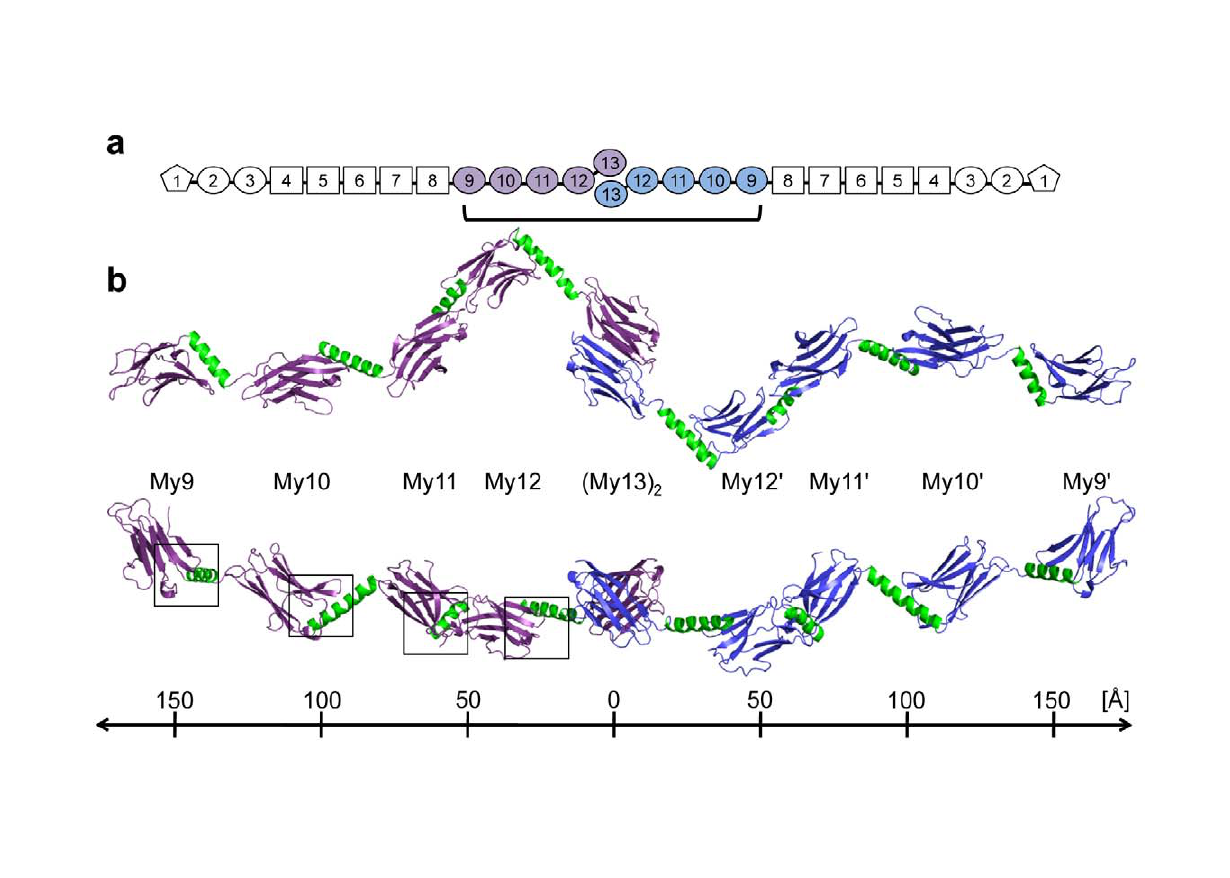
Figure 1. Overall filament architecture of the dimeric myomesin IgH domain array My9–My10–My11–My12–(My13) 2 –My12 9 –My11 9 – My10 9 –My9 9 . (A) Schematic representation of the complete myomesin dimer. Those My domains that have been structurally investigated are shown in violet (first molecule) and blue (second molecule). (B) Ribbon representation of the complete myomesin tail-to-tail filament structure, in two different orientations, rotated around a horizontal axis by 90 u . The helical linkers are shown in green. A ruler, providing an overall length estimate of the filament, is shown below. The conserved My domain/helix interface areas, shown in Figure 2B, are boxed.